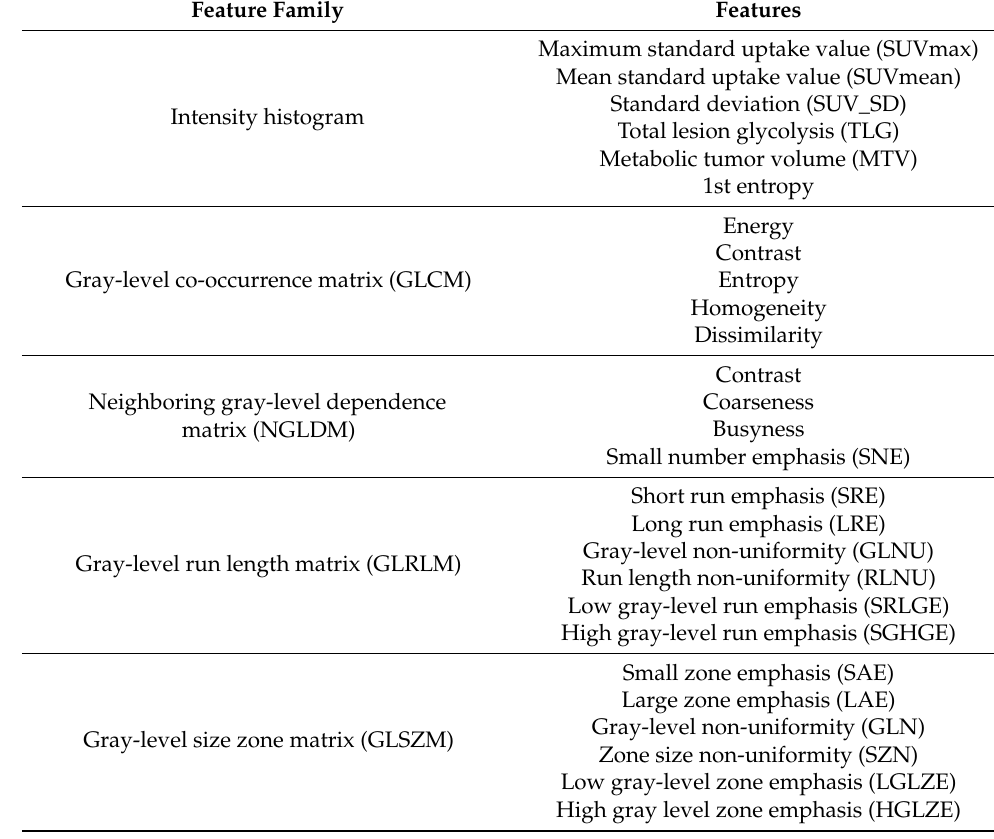
Table 3. Index of textural features in global, local, and regional